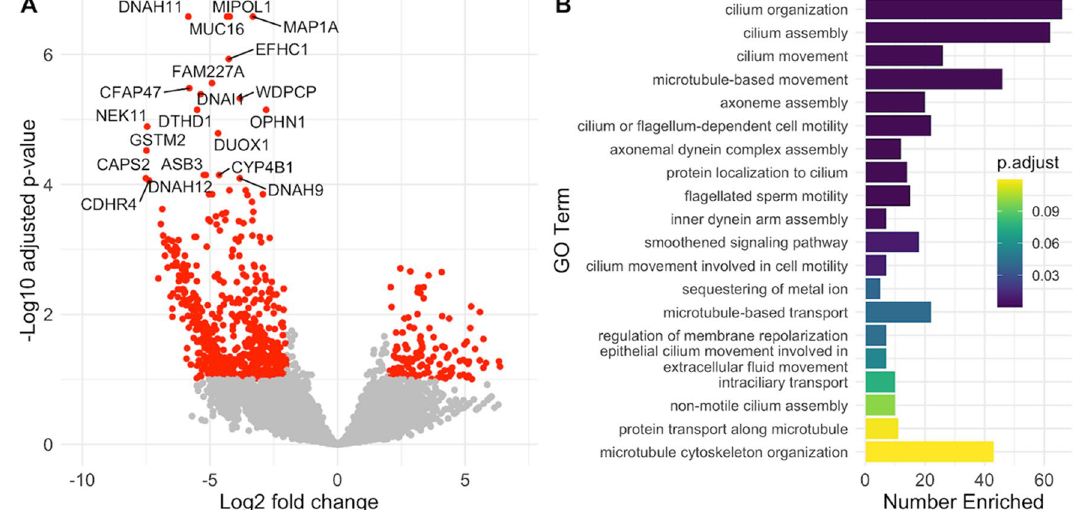
Figure 5. Differentially expressed genes during SARS-CoV-2 infection. ( A ) Twenty differentially expressed genes with lowest adjusted p value. Fold changes are of later samples relative to initial samples. Genes highlighted in red have a log2 fold change > 2 and an adjusted p value < 0.1. ( B ) Gene Ontology analysis reveals that differentially expressed genes are significantly enriched in biological processes related to microtubule- based motility. The twenty biological processes with the lowest adjusted p values are shown. The length of the horizontal bars corresponds to the number of DE genes in each GO category (“Number Enriched). Bar color corresponds to the adjusted p value for enrichment of DE genes in each